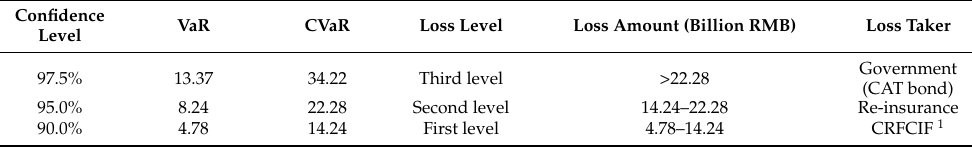
Table 3. Design of compensation mechanism according to VaR and CVaR of individual economic